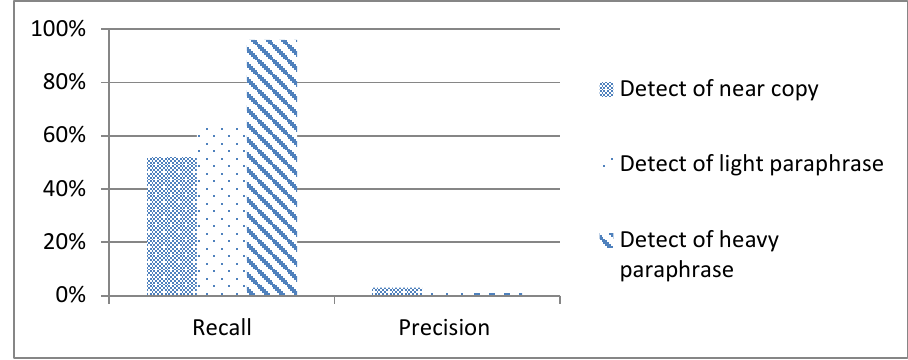
Figure 10. Evaluation of various paraphrasing types.